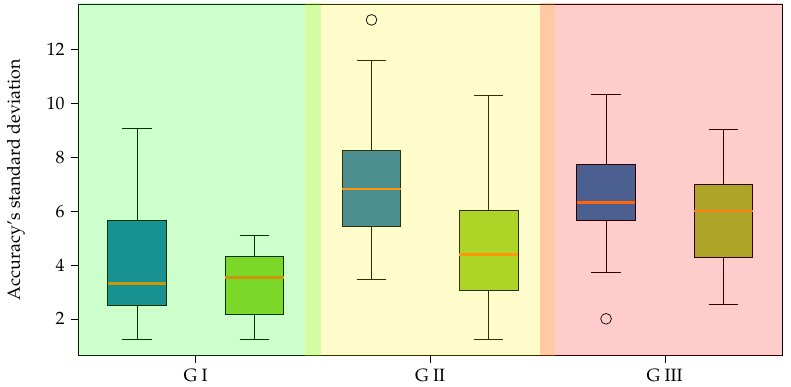
Figure 6. Group comparison between EEGnet (blue boxplots) and KCS-FCnet (green boxplots) concerning the accuracy’s standard deviation. The background codes the group membership (best— GI, medium—GII, and worst—GIII performance